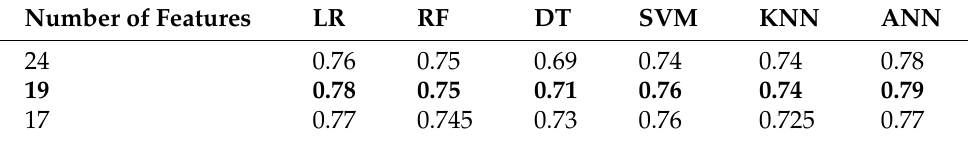
Figure 8. Feature importance based on a decision tree model. Table 5. Accuracy of different models based on different set of